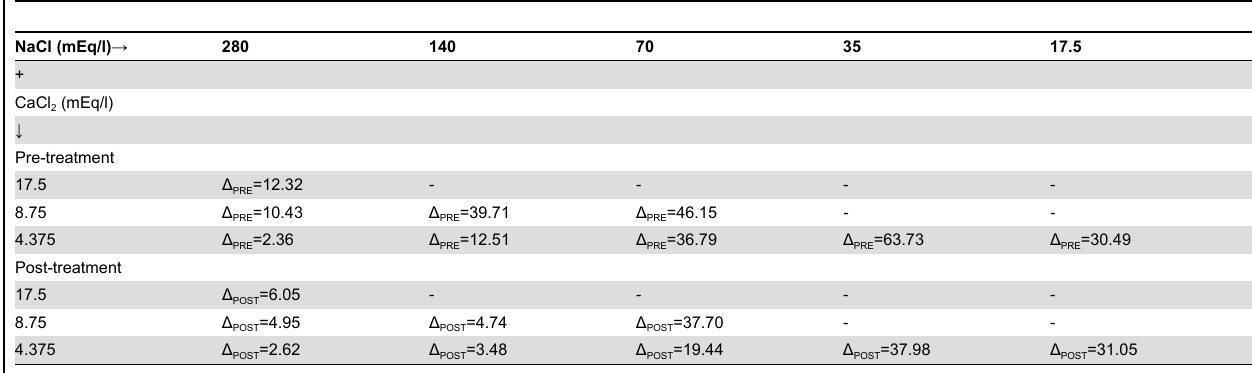
Table 3. Concentration of mixed samples (NaCl+CaCl compared to the samples with NaCl alone at the same concentration, pre- and post-resin treatment (Δ respectively).